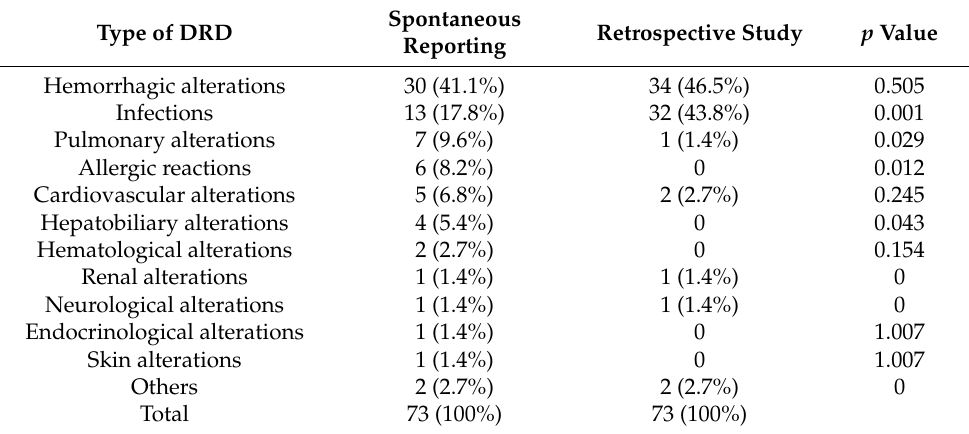
Table 10. Comparison of type of